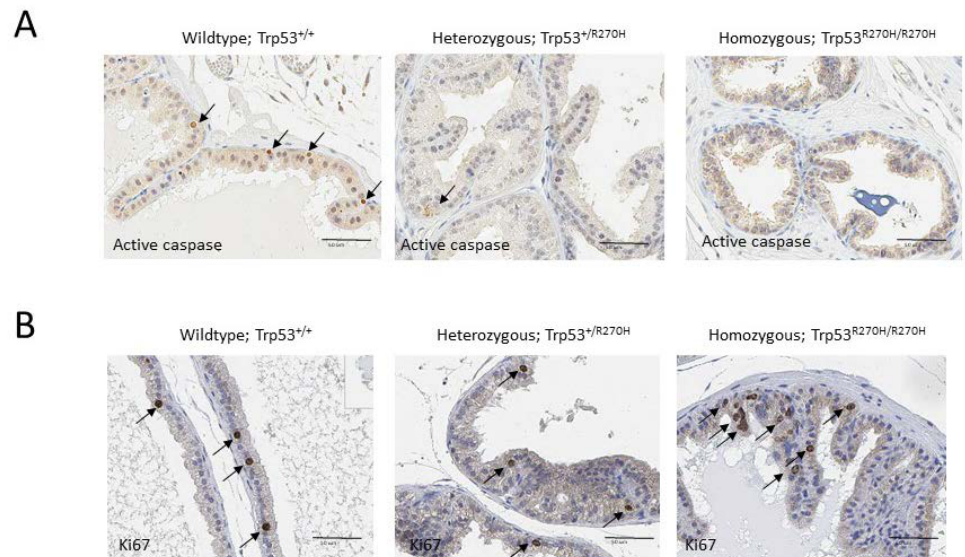
Figure 5. Presence of the Trp53 R270H mutant allele causes increased cell survival following irradi- ation but does not affect cell proliferation. All mice were exposed to 5 Gy whole body irradiation 6 h prior to time of necropsy. IHC analyses of revealed that ~5% of cells in prostates from wildtype mice ( Trp53 +/+ ) expressed active caspase 3 (arrows), compared to only ~1% of cells in prostates from heterozygous mice ( Trp53 +/R270H ) ( A ). Less than 1% of cells in prostates from homozygous mice ( Trp53 R270H/R270H ) expressed active caspase 3 ( A ). These data indicate that the Trp53 R270H mutant allele promotes survival of prostate cells. In contrast, Ki67 IHC revealed similar levels of cell proliferation (~2–5%) in all three genotypes ( B ).